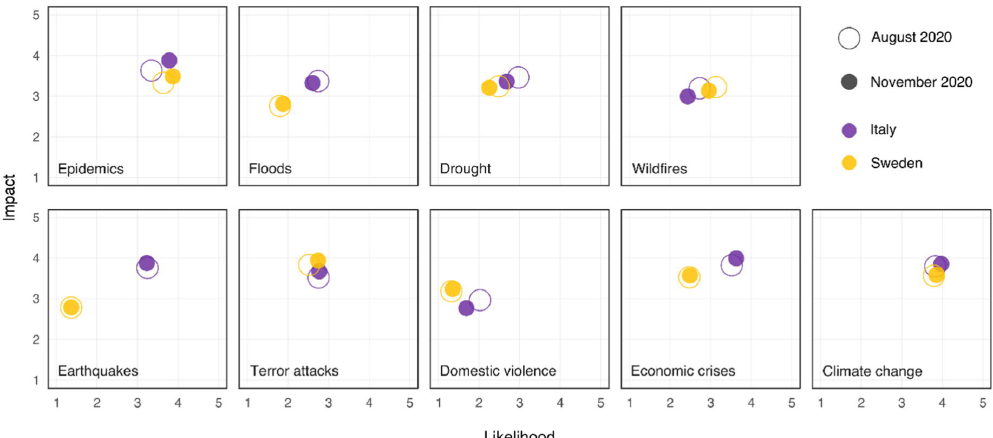
Figure 3. Perception of multiple risks in Italy and Sweden: national averages of perceived likelihood and impact in August and Novem- ber